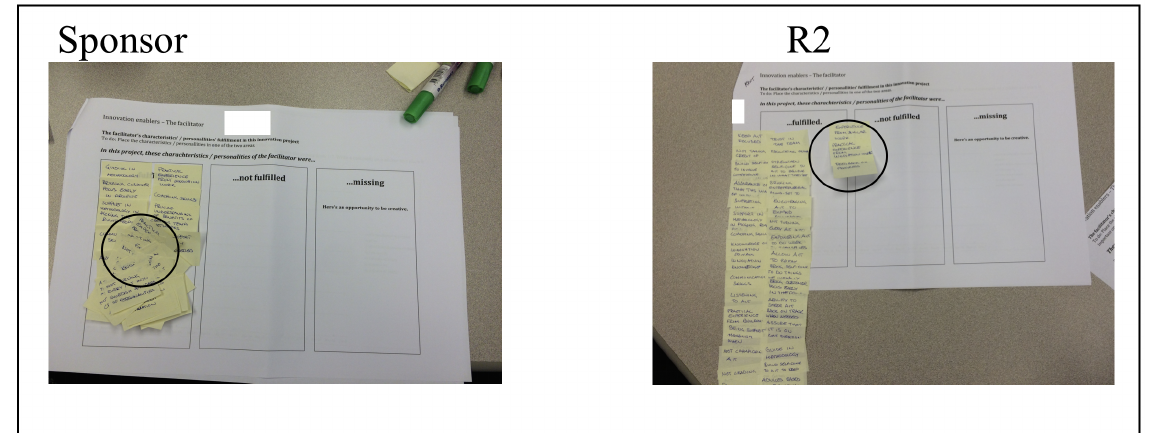
Fig. 1. The figure demonstrates the rated characteristics by the sponsor and Respondent 2